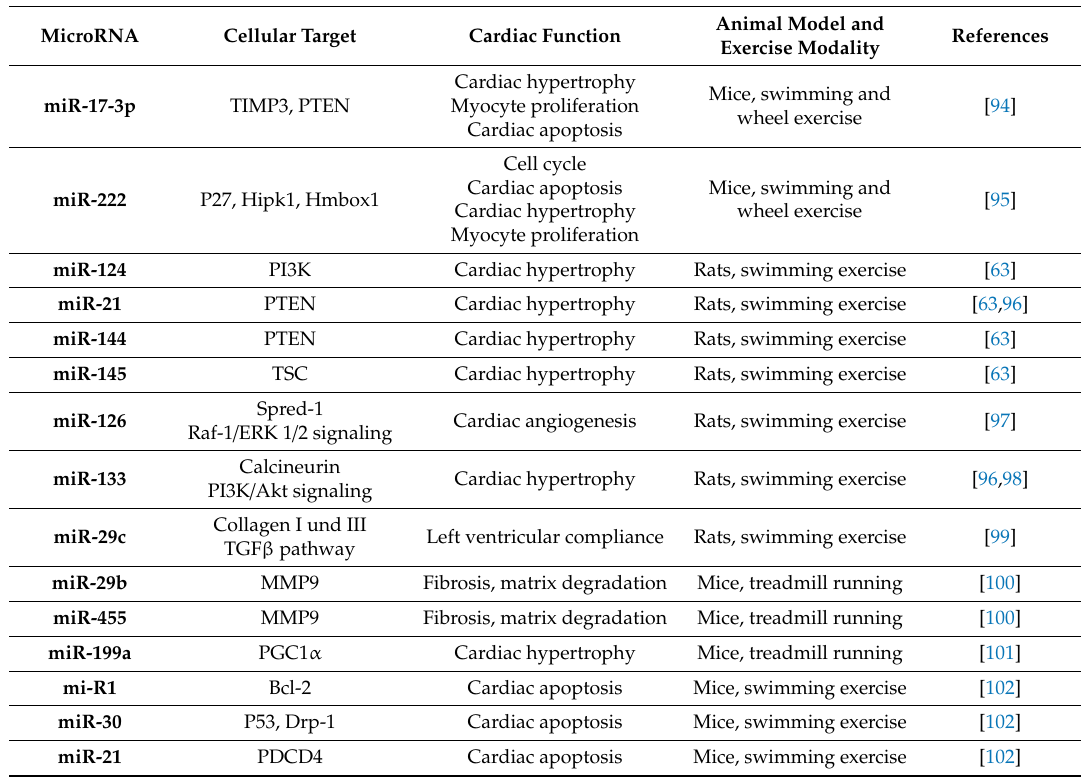
Table 1. Overview of microRNA levels altered in response to physical exercise and their contribution to